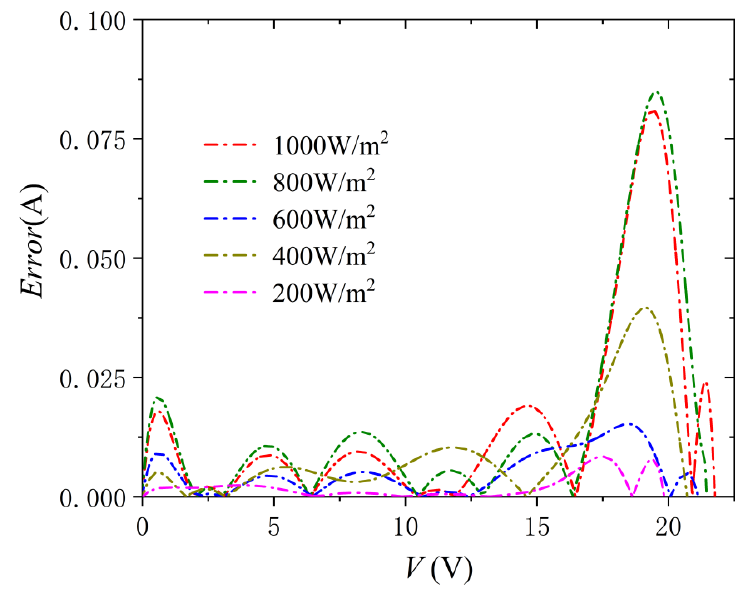
Figure 8. P-V characteristics measured and calculated, respectively, for the thin-film SM55 PV panel in different irradiance conditions.